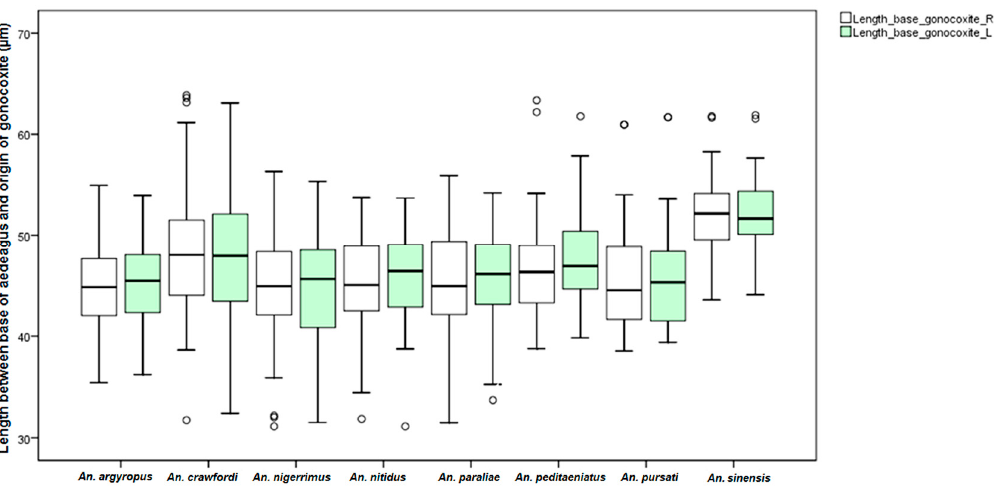
Figure 10. The Box-and-Whisker Plots representation of variation in length between base of aedeagus and origin of gonocoxite of adult male of the eight Hyrcanus Group species.